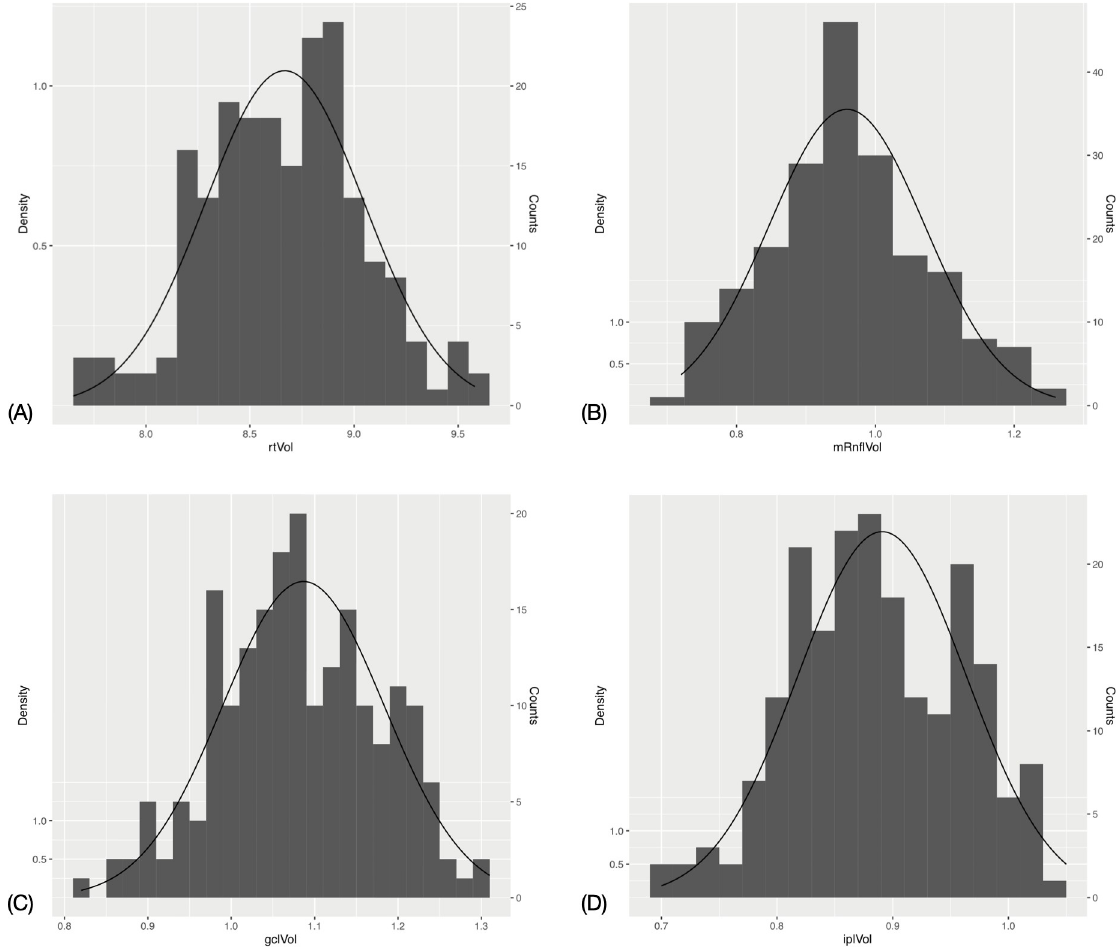
Fig 1. Histogram and fitted normal distribution curves of macular optical coherence tomography measurements. (A) Total retinal volume. (B) Retinal nerve fibre layer volume. (C) Ganglion cell layer volume. (D) Inner plexiform layer volume.